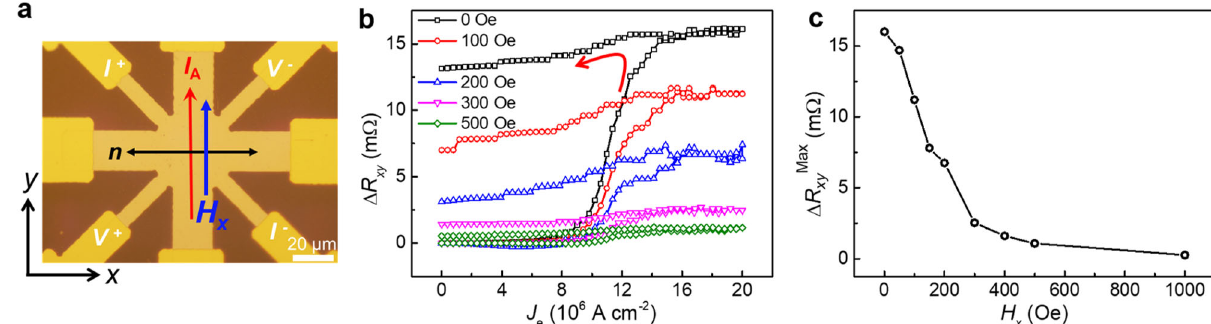
Fig. 4 Magnetic bias fi eld dependence of Néel vector switching. a Schematic of the magnetic bias fi eld dependence measurement. An external magnetic bias fi eld H x along the writing current direction is applied during the current-driven Néel vector switching. b Current-driven Néel vector switching at